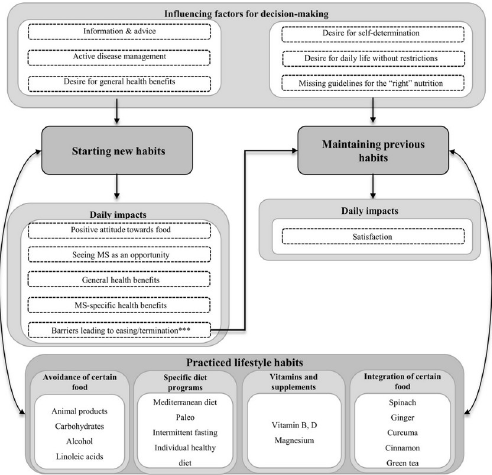
Fig 1. Sub-themes of nutrition and supplements. ��� Barriers arising while starting new habits resulted in the resumption of previous habits prior to the diagnosis of MS.